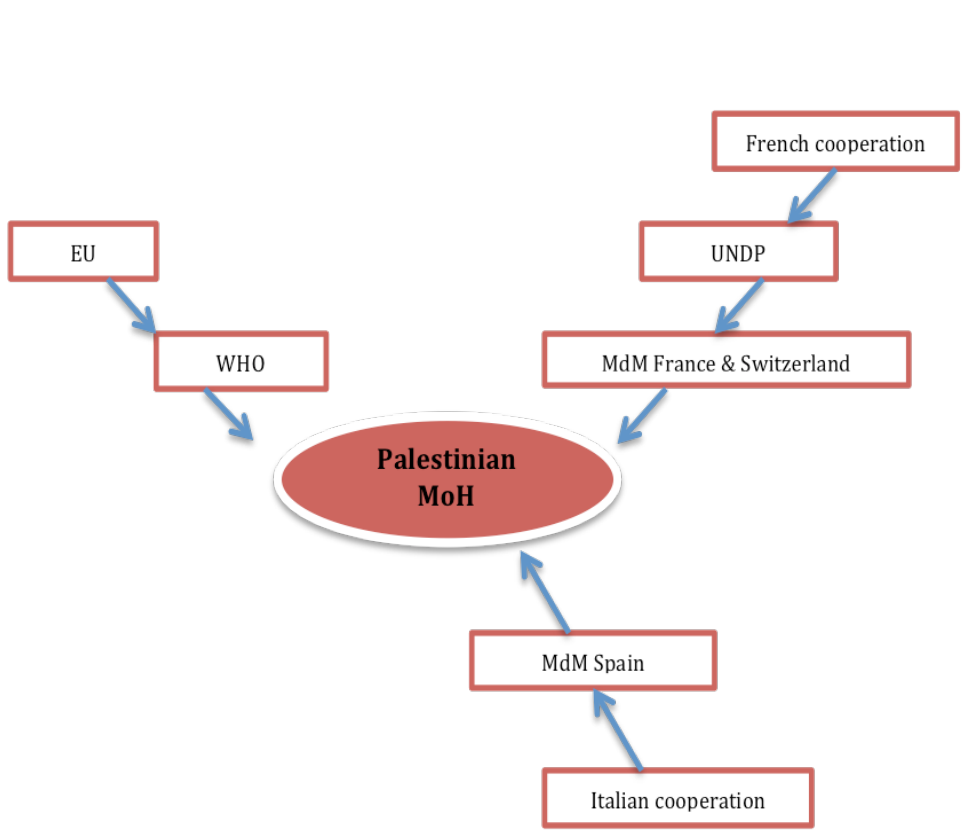
Figure 1. Financial flows to the Palestinian Ministry of